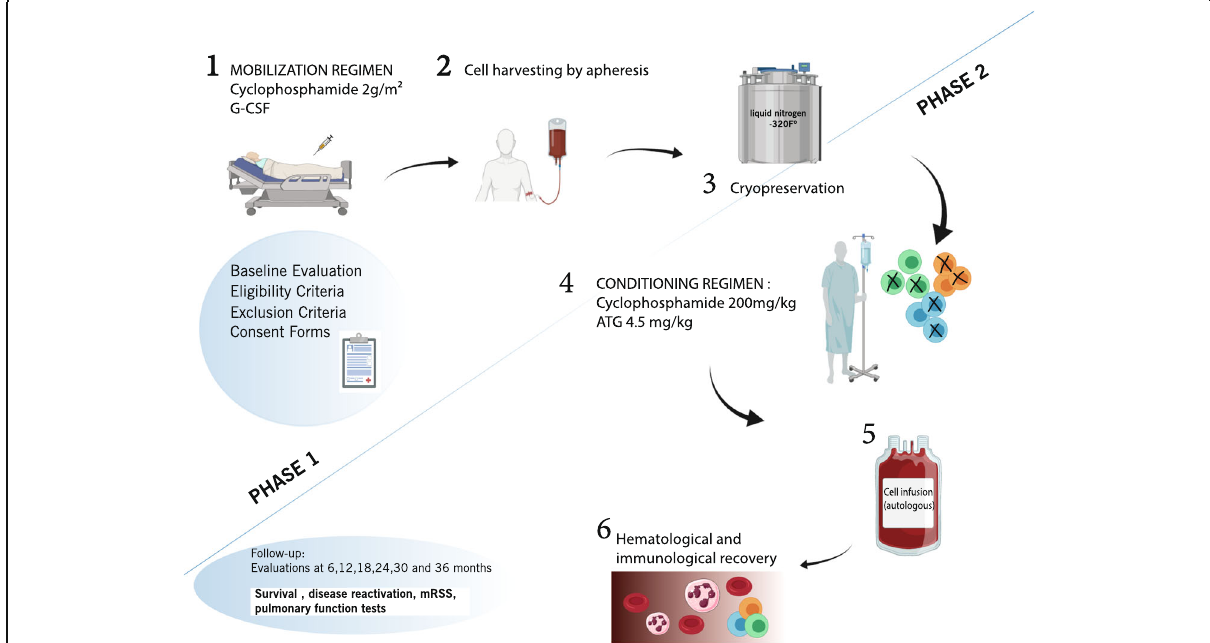
Fig. 1 Study design. Hematopoietic stem cell transplantation comprises two phases. In phase I, patients that fulfill the inclusion criteria for transplantation are thoroughly evaluated for organ involvement, eligibility and exclusion criteria (baseline evaluation). Then, progenitor hematopoietic cells (CD34+) are mobilized from the bone marrow to the peripheral blood by a regimen of cyclophosphamide plus granulocyte- colony stimulating factor (G-CSF). Circulating CD34+ cells are harvested from the peripheral blood through apheresis and cryopreserved, without further manipulation. In phase 2, which begins at least 2 weeks after phase 1, patients are treated with a conditioning regimen consisting of combined high-dose chemotherapy and immunotherapy agents, usually cyclophosphamide 200 mg/kg plus anti-thymocyte globulin (ATG). Subsequently, the previously harvested autologous progenitor cells are thawed at bedside and administered to the patient, intravenously. A period of bone marrow aplasia follows, lasting approximately 7 days, ended by hematological and immunological recovery. Patients are followed- up periodically for hematological and immunological reconstitution and clinical outcomes, until 5-years of